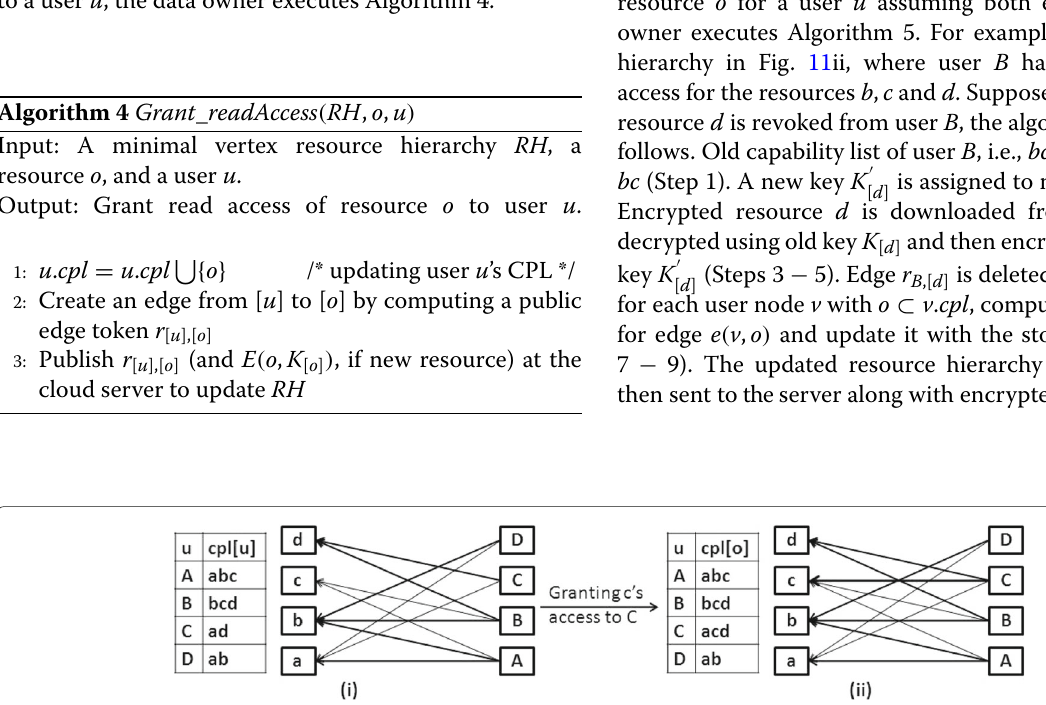
Fig. 11 ( i ) An example minimal vertex resource hierarchy, and ( ii ) Granting read access for resource c to user